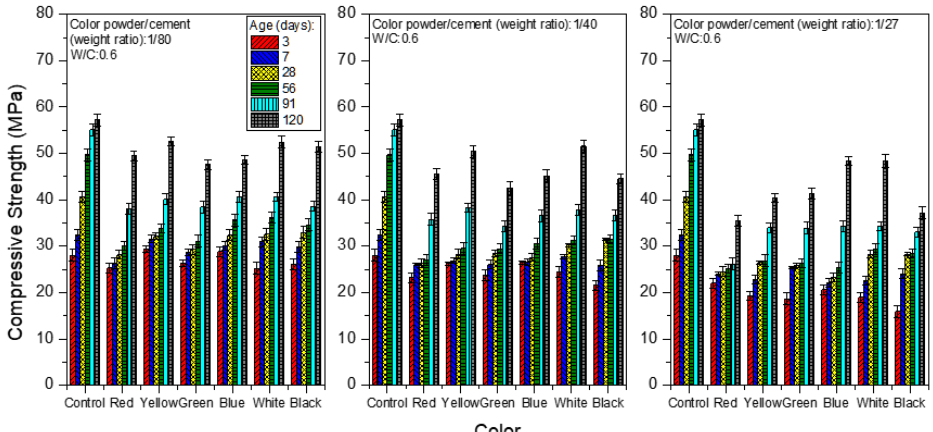
Figure 7. Compressive strength of colored mortar at W/C = 0.6 and under saturated limewater cur- ing when weight ratios of color powder/cement at 1:80, 1:40, and 1:27 are